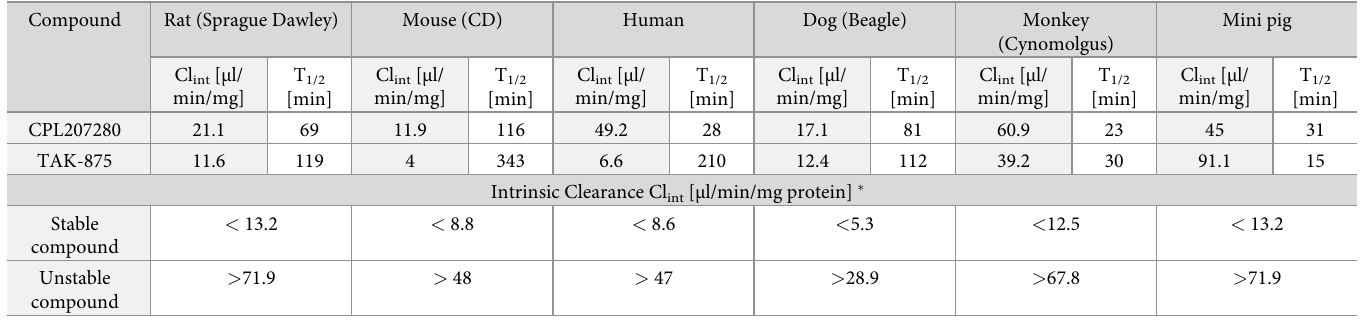
The test compounds were incubated with microsomes for 0, 10, 20, 40, 60, and 120 min, after which the supernatant was subjected to LC-MS/MS analysis for quantitative assessment of test compounds. Data represent the mean half-life of the parent compound, T 1/2 , and mean intrinsic clearance, CL int (n = 2). Based on the mean clearance data, the extent of metabolism from greatest to least was monkey � human >> dog � rat > mouse. � Reference ranges of values by Cyprotex.